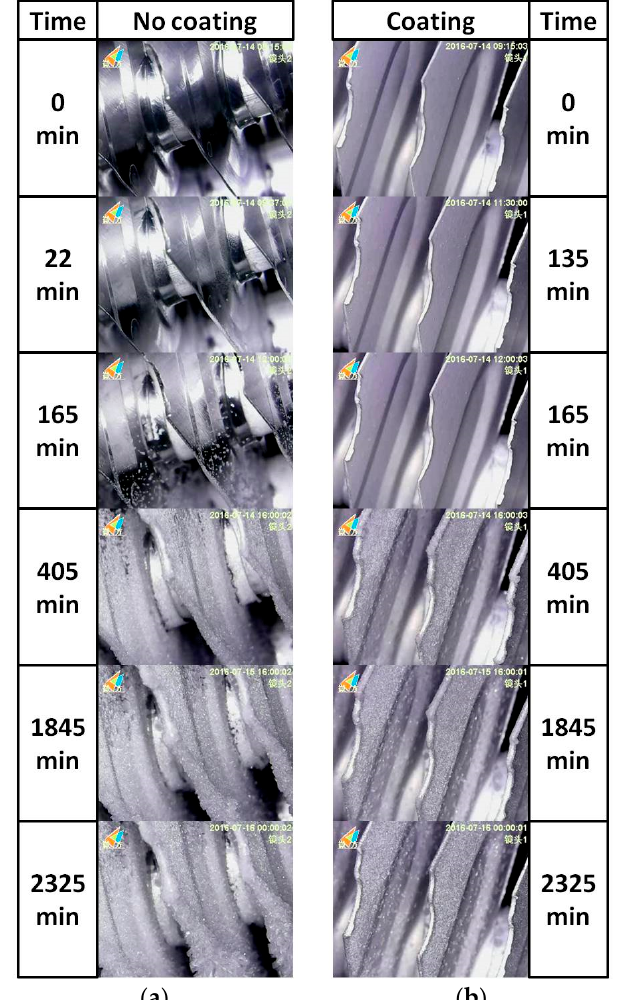
Figure 6. Frost formation process and variation of frost mass with time for ( a ) uncoated and ( b ) PDMS-SiO 2 /SS hybrid coated surfaces.